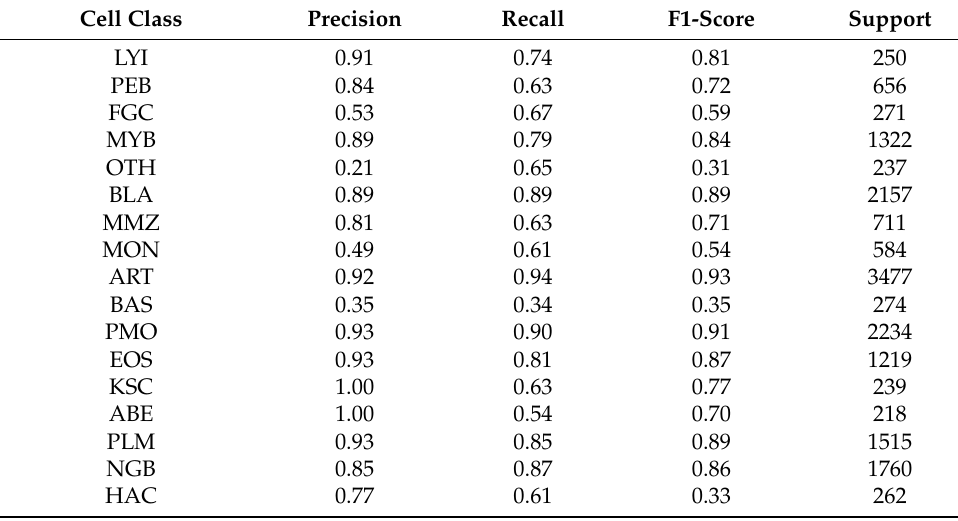
Table 4. Evaluation metrics score for different cell classes on validation